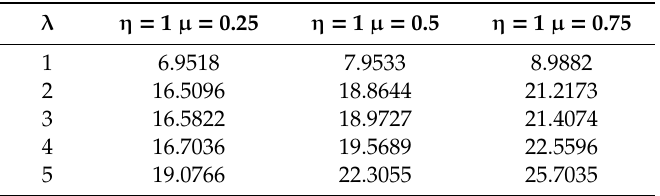
Table 9. First five natural frequencies for the USFG distribution for three di ff erent states of complete